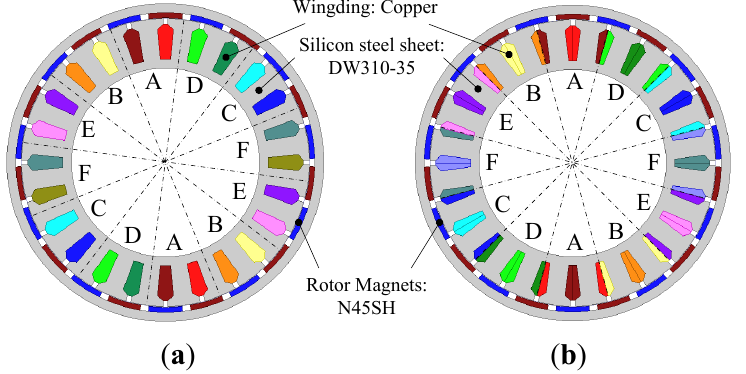
Figure 3. Cross-section diagram of two winding dispositions of a 24-slot/22-pole outer rotor semi-12-phase PMSM equipped with FSCWs: ( a ) Alternate teeth wound scheme; ( b ) All teeth wound